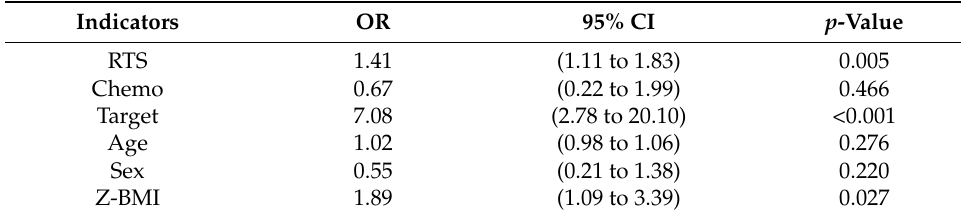
Table 2. Logistic regression for 6-month survival rate in group